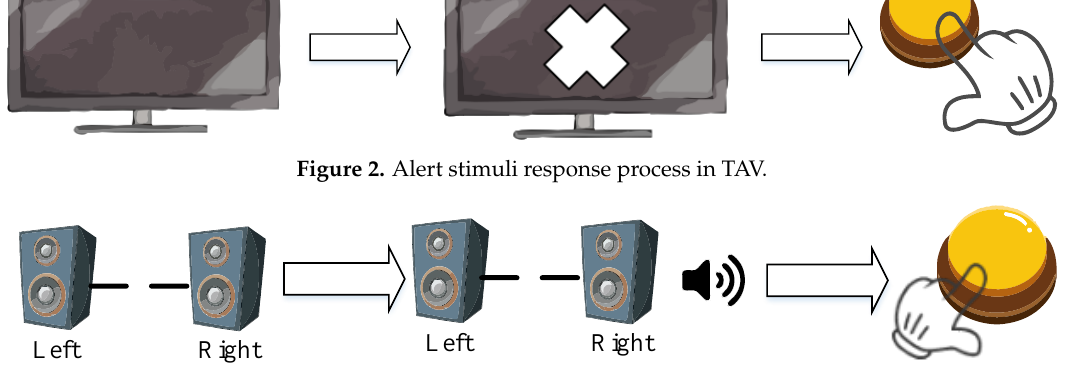
Figure 3. Vigilance stimuli response process in